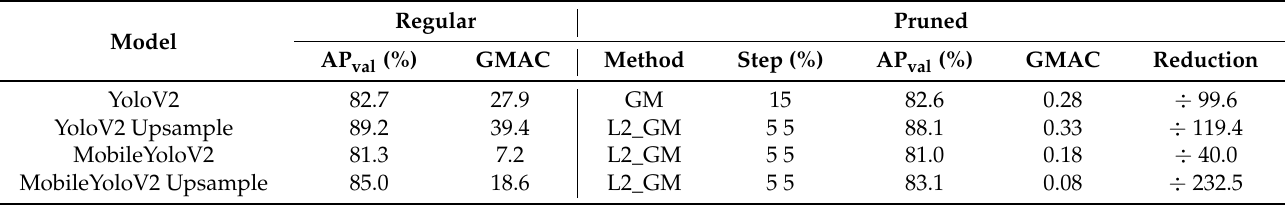
Figure 12. Accuracy (AP) vs computational complexity (MAC) of the pruned models on the LWIR Railway Surveillance validation data. Note the red horizontal and vertical lines, which indicate the values of the unpruned models. The Y-axis does not start at zero, in order to more clearly show the small differences in accuracy and the X-axis is on a logarithmic scale. Table 7. Accuracy (AP) and complexity (GMAC) of the regular models, compared with the best pruned version of each model. Accuracy is computed on the LWIR Railway Surveillance validation